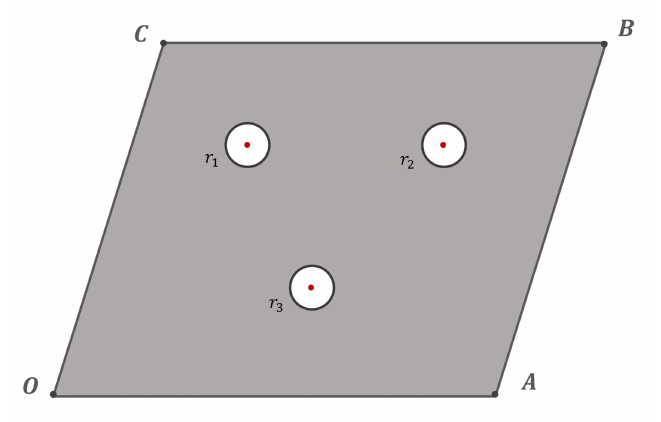
Figure 1 . The regularized cell for f ( z, ¯ z ) contains three singularities (red points). The grey part bounded by the solid lines is the regularized integral